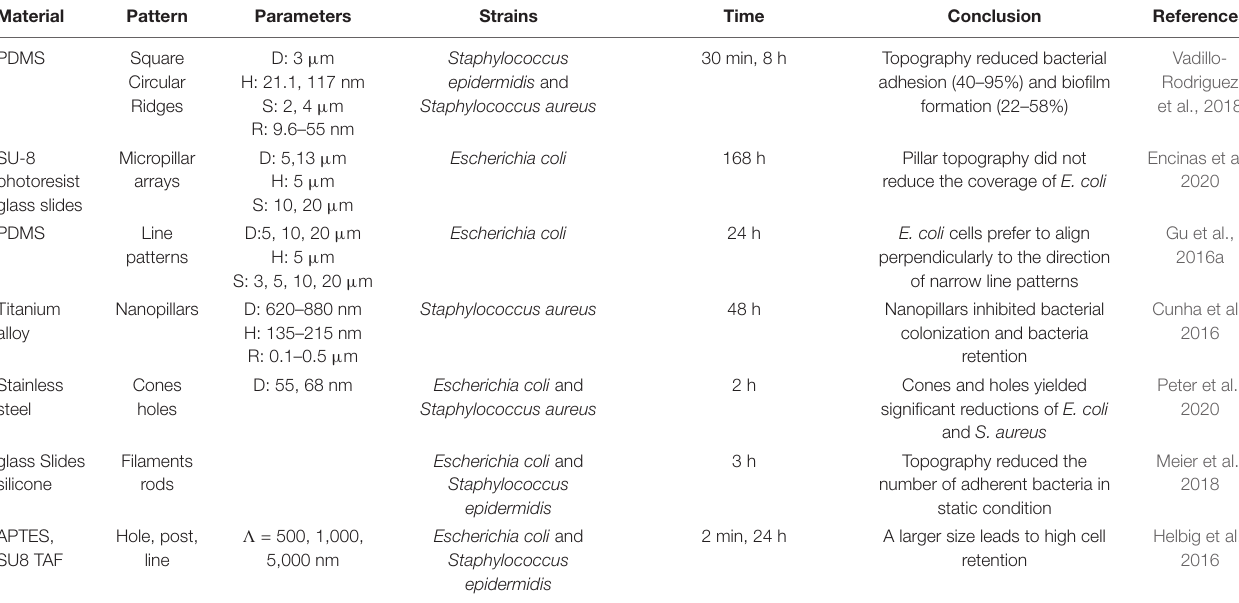
FIGURE 1 | Schematic illustration of the review. Bacteria can form biofilms once attached to a substrate that can be beneficial or problematic depending on specific situations. A thorough understanding of biofilm formation factors and their properties is necessary for better application. Both genomic modifications of the bacteria and substratum’s properties can affect biofilm’s properties. Currently, little research has focused on combining these two methods to control biofilm formation. In this article, we propose that by taking advantage of both synthetic biology and materiobiology, it is possible to gain better control over biofilm formation. TABLE 1 | Summary of the effects of patterned substrates on bacterial adhesion